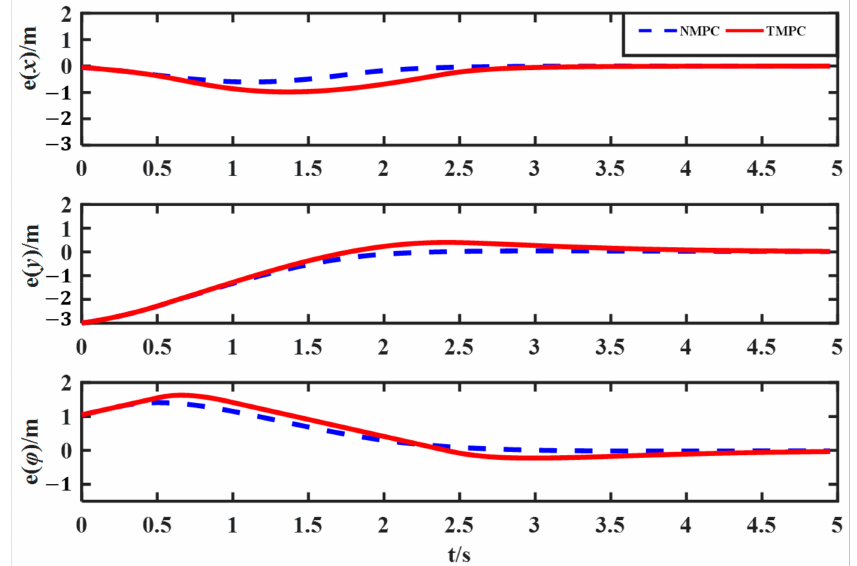
Figure 4. The tracking errors of x , y and ϕ under the ST.